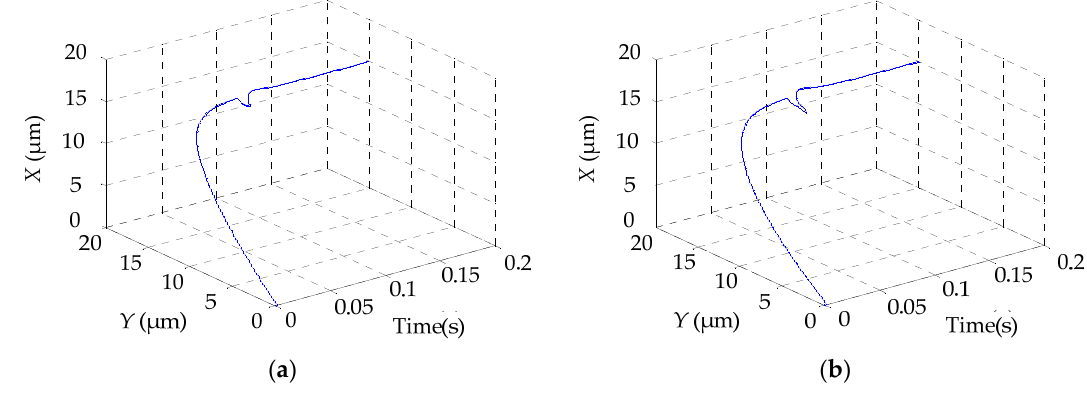
Figure 9. Comparison of platform trajectory: ( a ) proposed control model based on inverse system; ( b ) traditional control model.